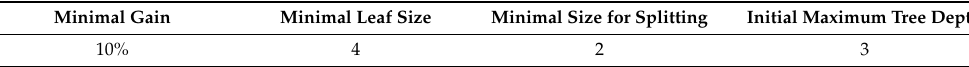
Table A3. Induction rules